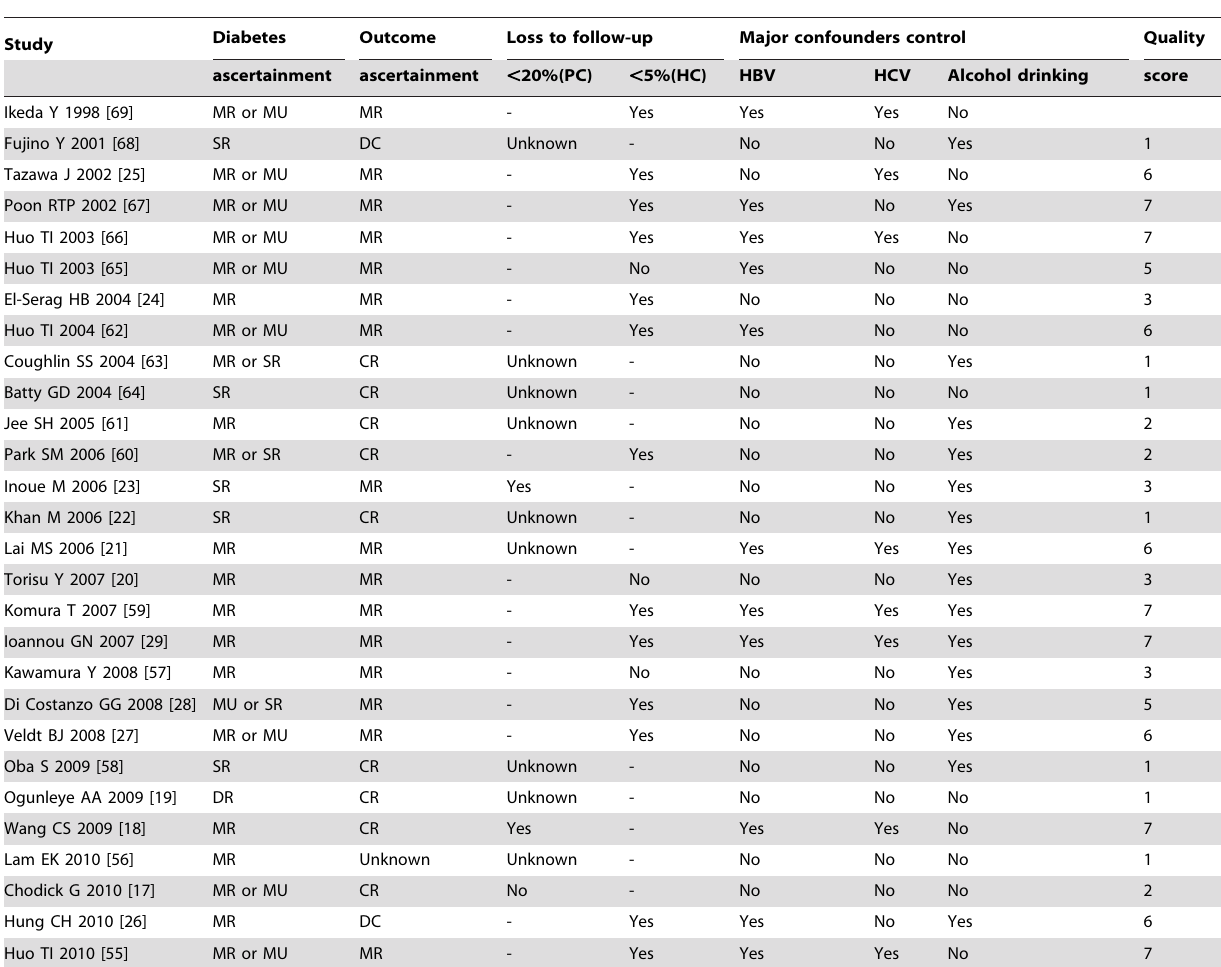
Table 1. Assessment of study